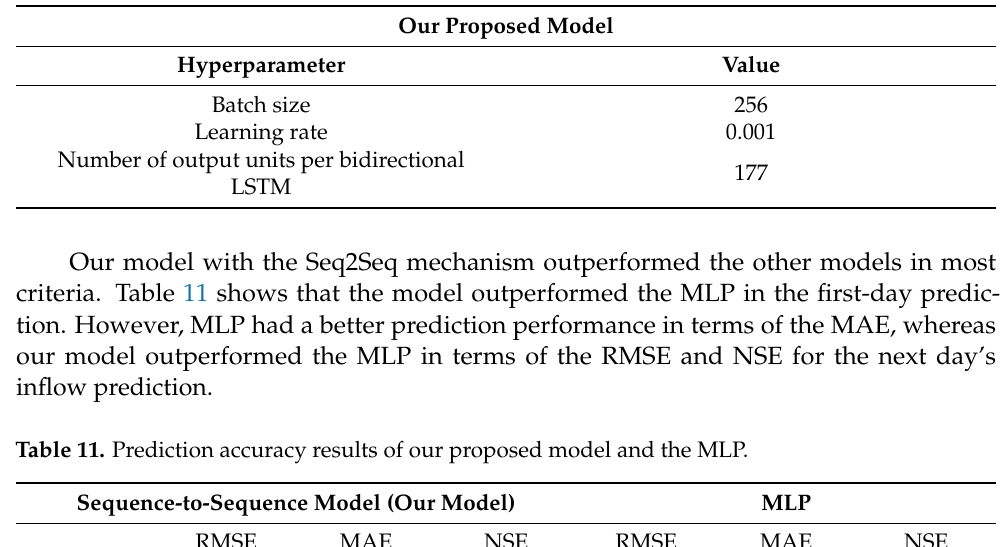
Table 10. Hyperparameter values for our model.